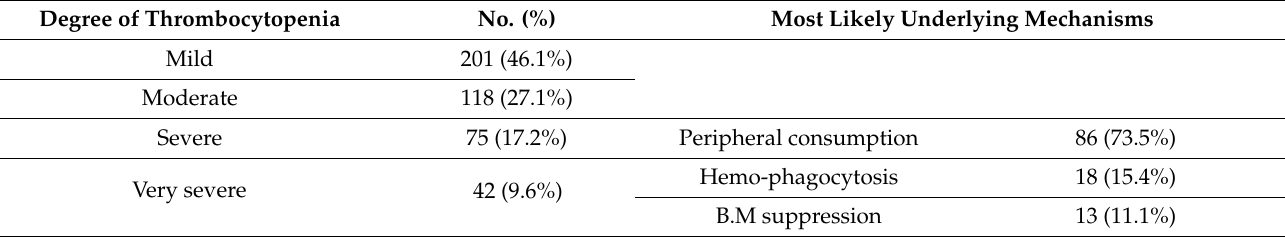
Table 2. Degrees of thrombocytopenia and the most likely underlying mechanisms.